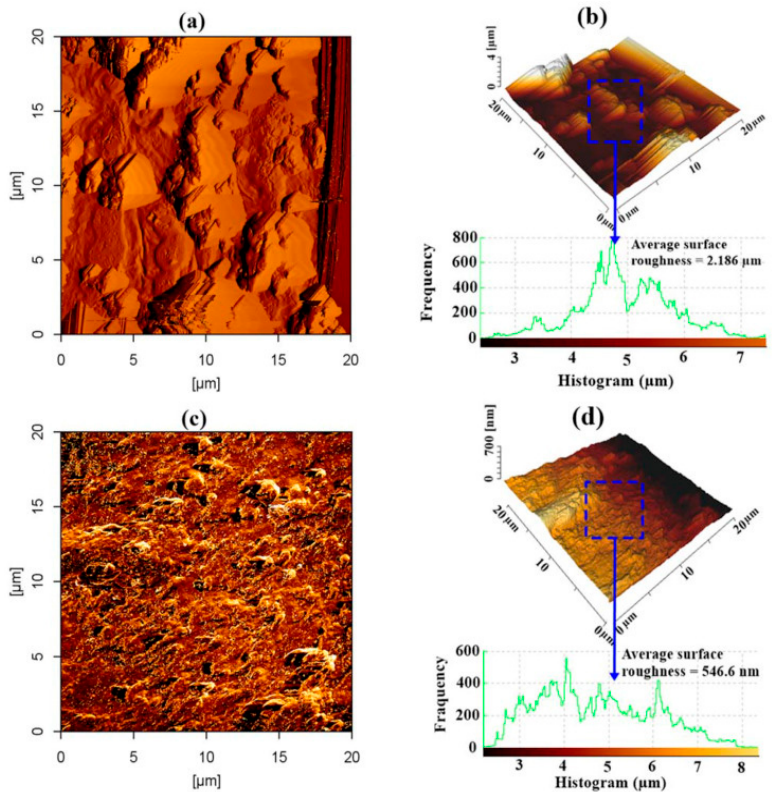
Figure 13. AFM scans for steel reinforcement substrates subjected to CO 2 for a duration of 180 days: ( a , b ) 2D, 3D scans for regulated and ( c , d ) 2D, 3D scans for inhibited samples including GA-NPs. Reprinted with permission from Ref. [83]. MDPI 2021.